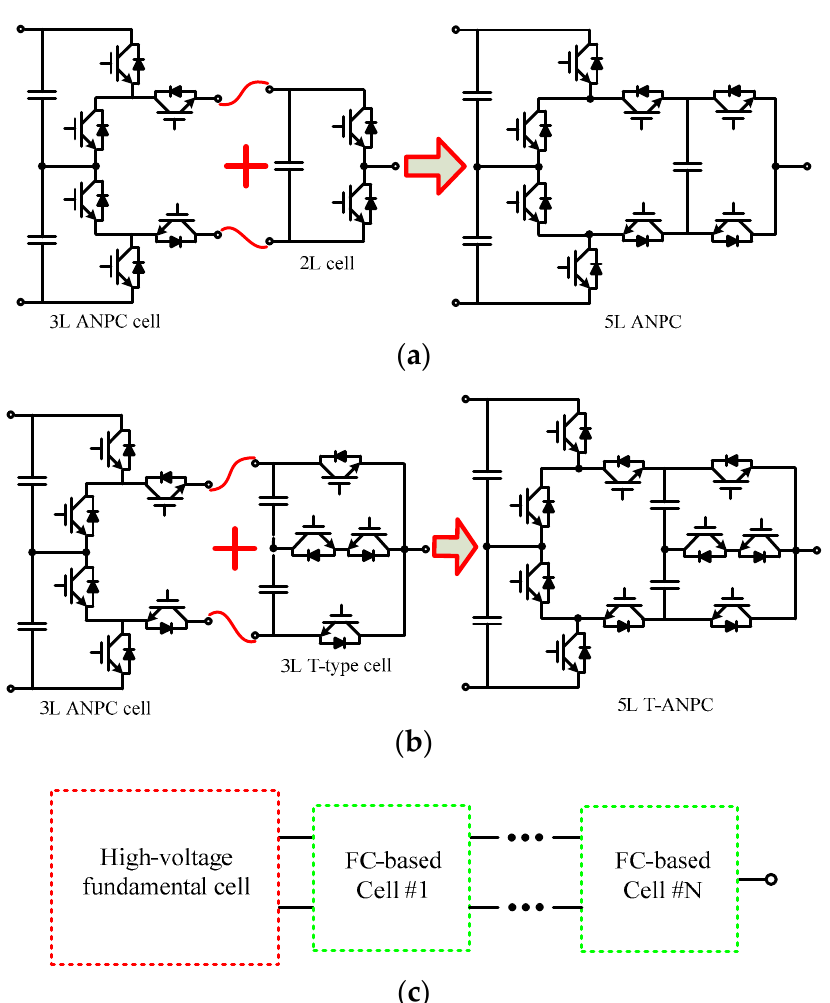
Figure 12. Derivation process of hybrid FC-based ANPC converters. ( a ) 5L ANPC, ( b ) 5L hybrid T-ANPC [40], ( c ) general structure with N FC-based cells.